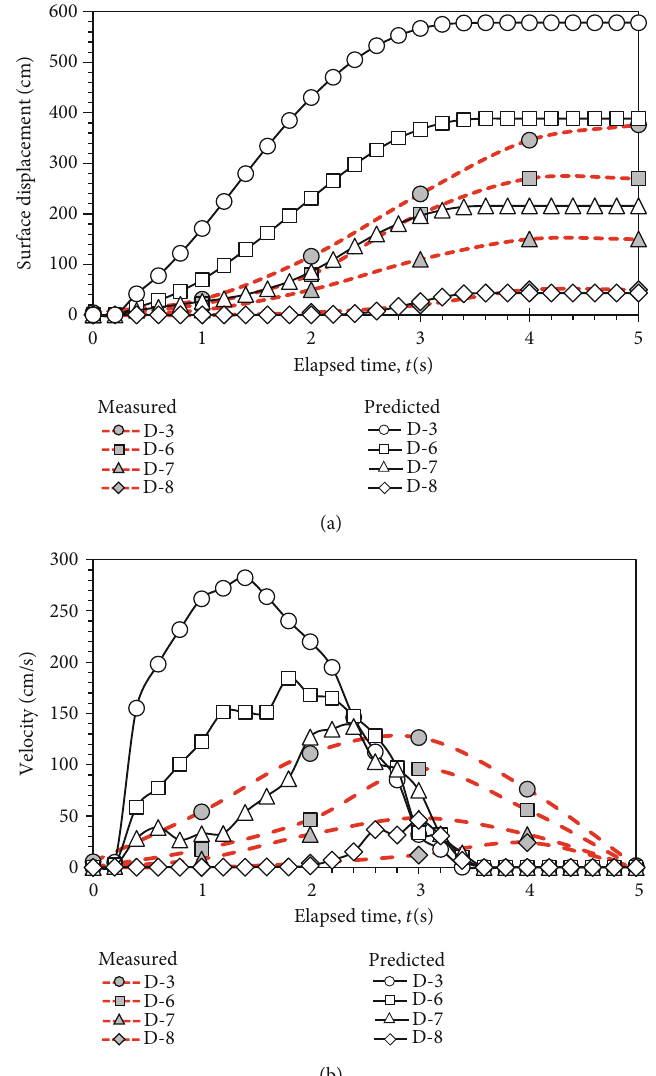
Figure 5: Comparison of predicted and measured (a) surface displacement and (b) velocity at di ff erent locations along the slope